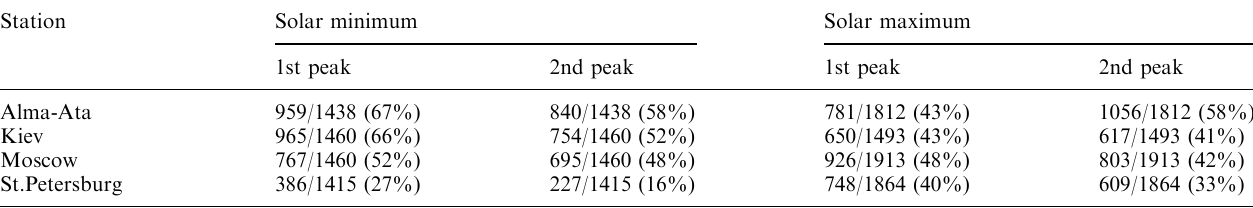
Table 1. Total number of cases (upper) of all quiet days (bottom) considered Station